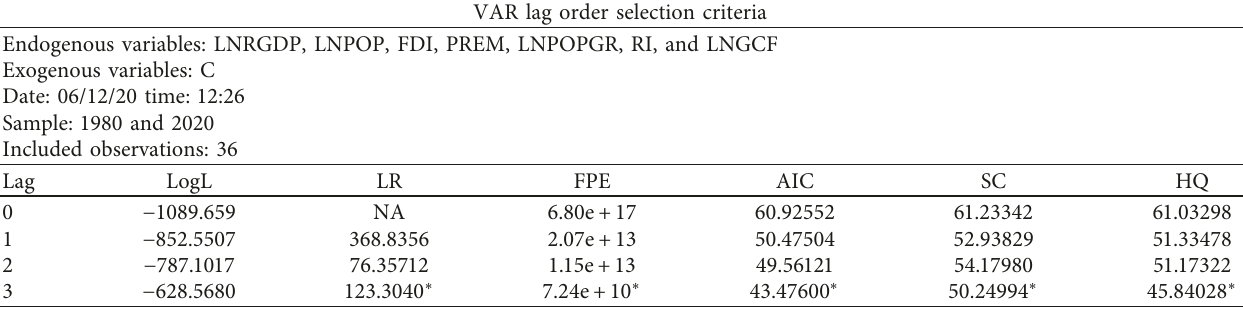
Table 2: Lag selection criteria from VAR criteria. VAR lag order selection criteria